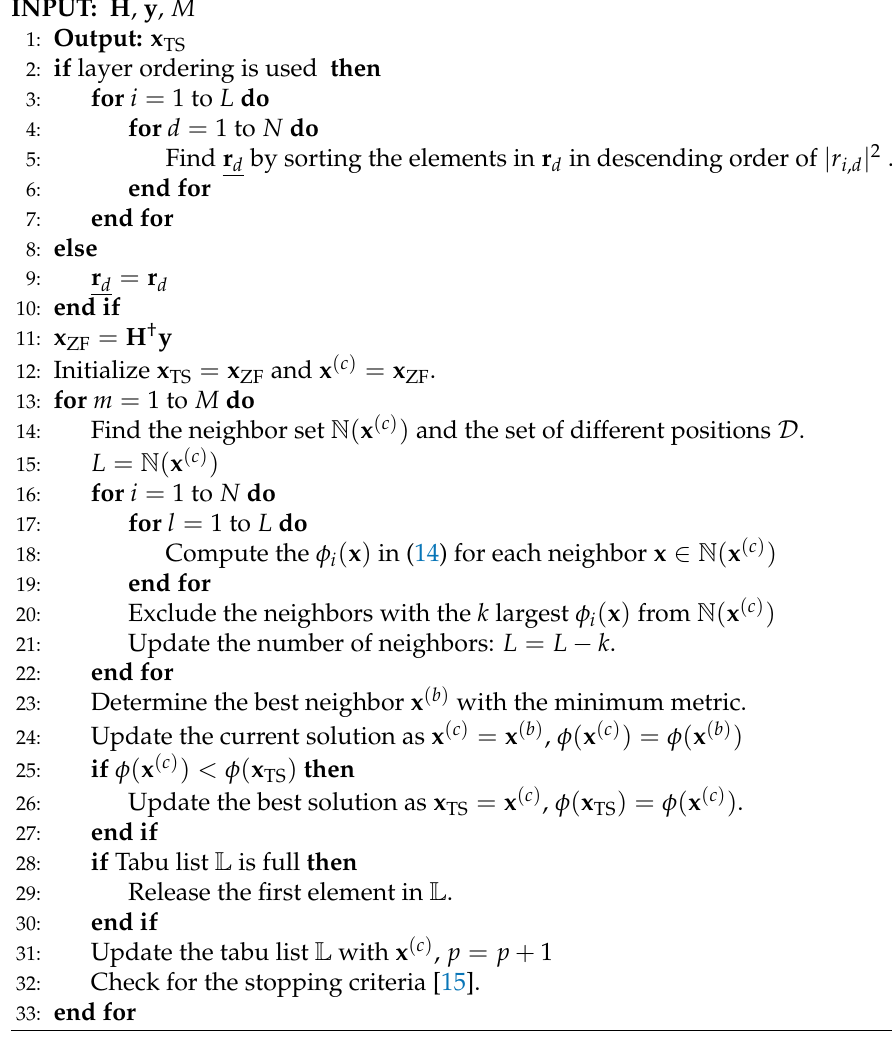
Algorithm 1 ENR-QR-TS with layer